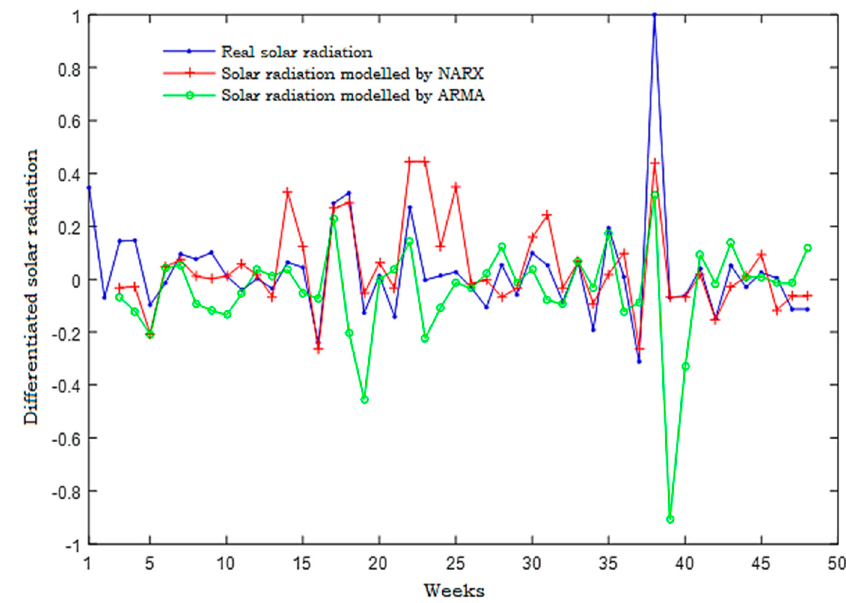
Figure 33. Solar radiation prediction using ARMA and NARX.